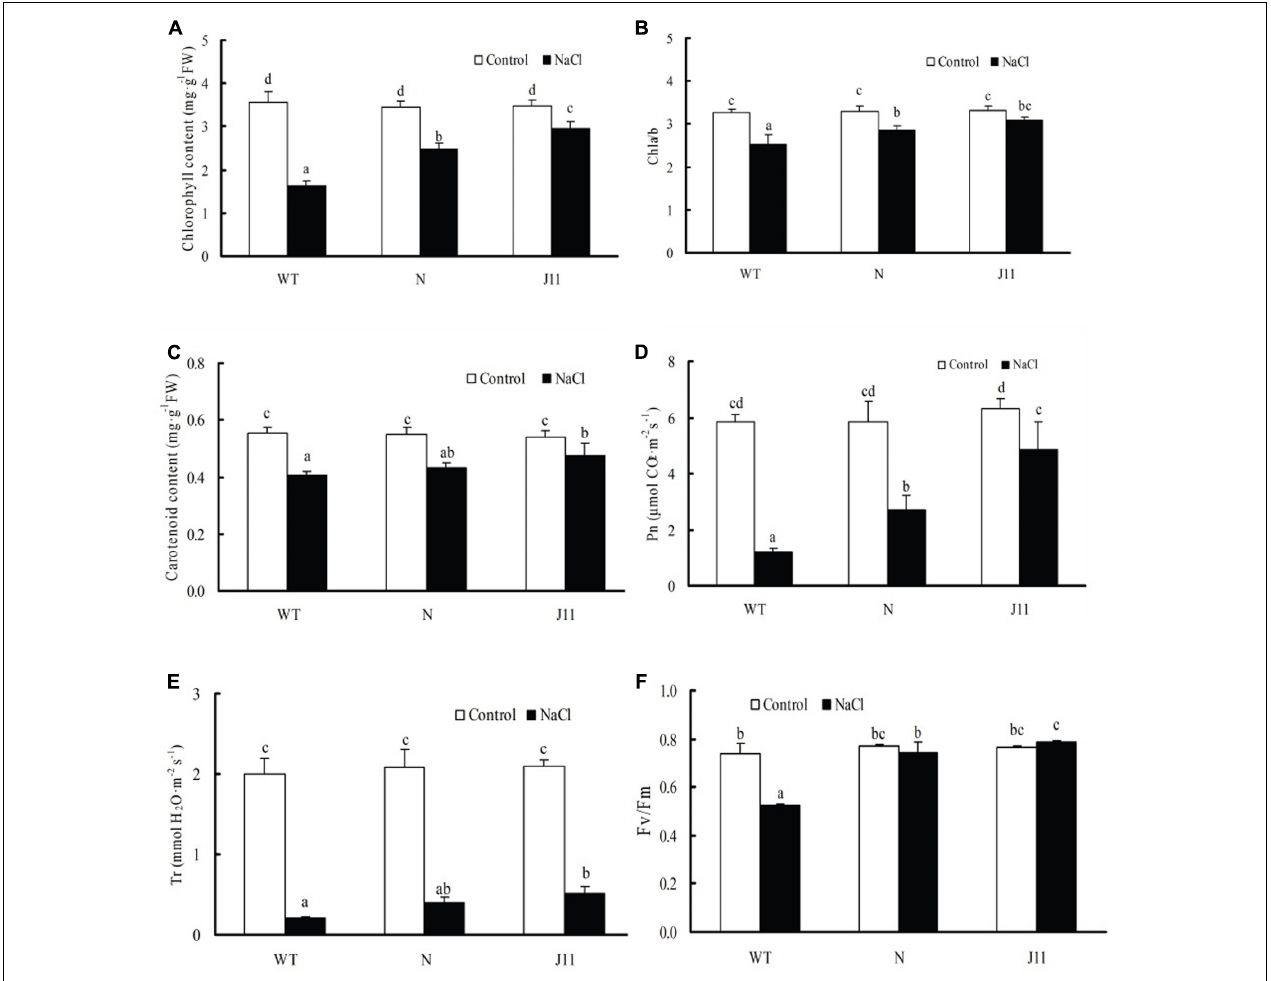
FIGURE 5 | Changes in photosynthetic parameters in leaves of WT and PgTIP1- transgenic soybean lines under NaCl treatment. The plants of WT and PgTIP1 transgenic soybean lines N and J11 were cultured and NaCl-treated as above-mentioned in Figure 4 . After 7 days treatment, the 1st pair of unifoliate leaves were sampled for measuring (A) chlorophyll content, (B) chla/b, (C) carotenoids content, or used for measuring (D) Pn, (E) Tr, and (F) F v/ F m in leaves of WT and PgTIP1- transgenic soybean lines. Each bar represents the mean and SD of three replicates, means in bars followed by different letters show significant difference ( P < 0.05) between the parameters of WT and PgTIP1- transgenic